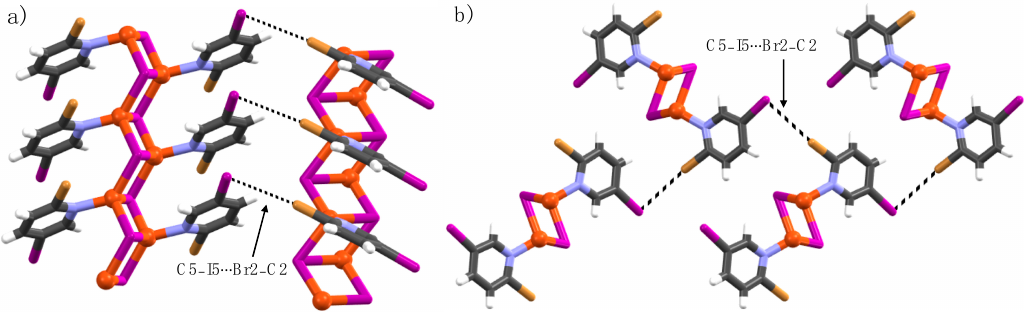
Figure 3. ( a , b ) X-Ray crystal structure of 3a viewed from two different directions. Halogen bonds are depicted by using black dotted lines.